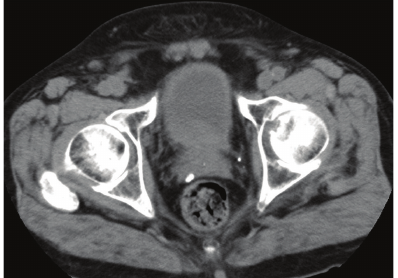
Figure 4: Precontrast CT demonstrated a diminution of the size of the lymphoma of the prostate 25 months after the prostate